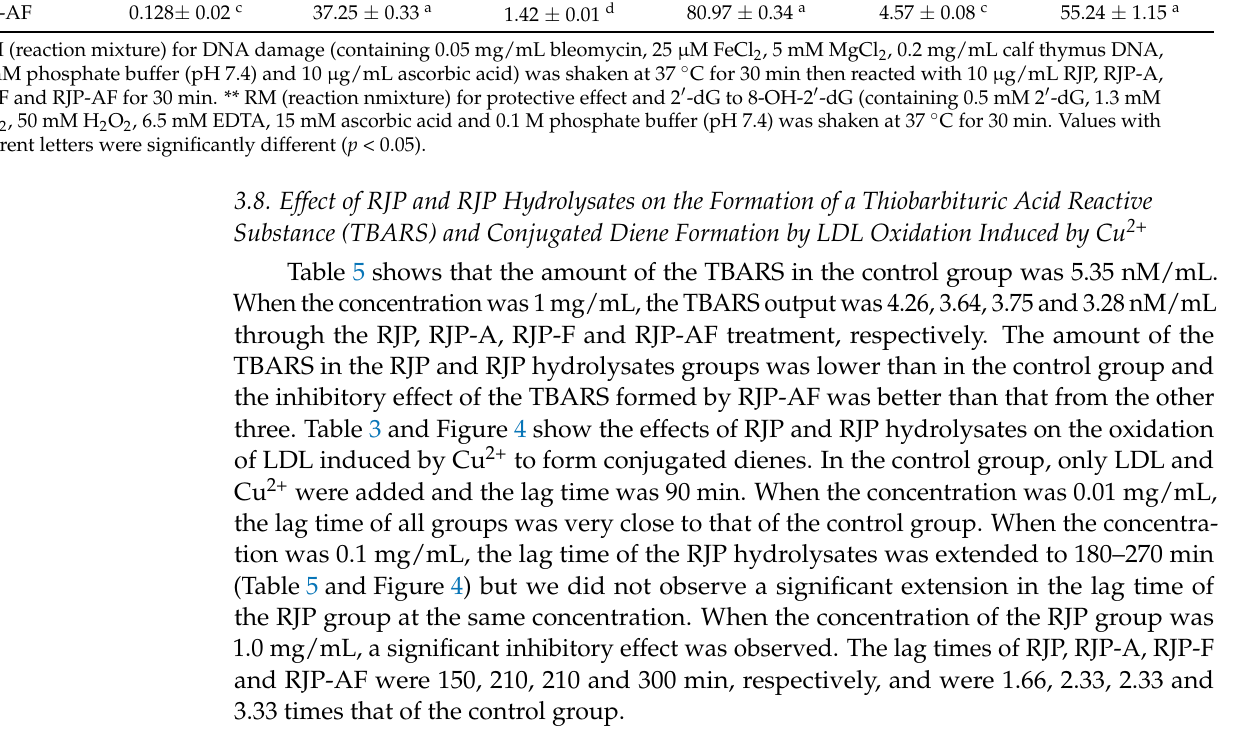
* RM (reaction mixture) for DNA damage (containing 0.05 mg/mL bleomycin, 25 µ M FeCl 2 , 5 mM MgCl 2 , 0.2 mg/mL calf thymus DNA, 30 mM phosphate buffer (pH 7.4) and 10 µ g/mL ascorbic acid) was shaken at 37 ◦ C for 30 min then reacted with 10 µ g/mL RJP, RJP-A, RJP-F and RJP-AF for 30 min. ** RM (reaction nmixture) for protective effect and 2 (cid:48) -dG to 8-OH-2 (cid:48) -dG (containing 0.5 mM 2 (cid:48) -dG, 1.3 mM FeCl